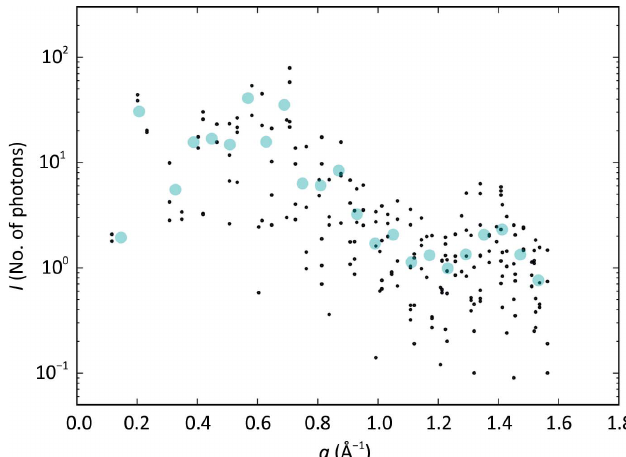
Figure 12 Final reflection intensities. The intensities I of the reflections from integration of the image sums, shown as a function of the in-plane momentum transfer q . The large cyan circles are resolution-bin